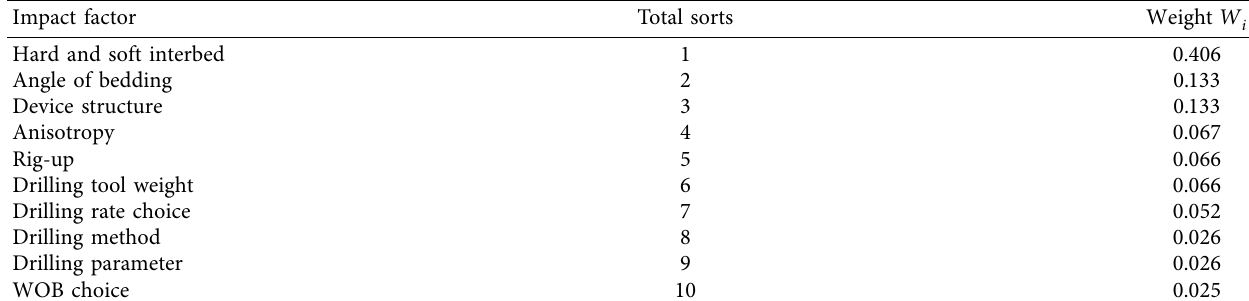
Table 6: Overall ranking of synthetic weights of evaluation